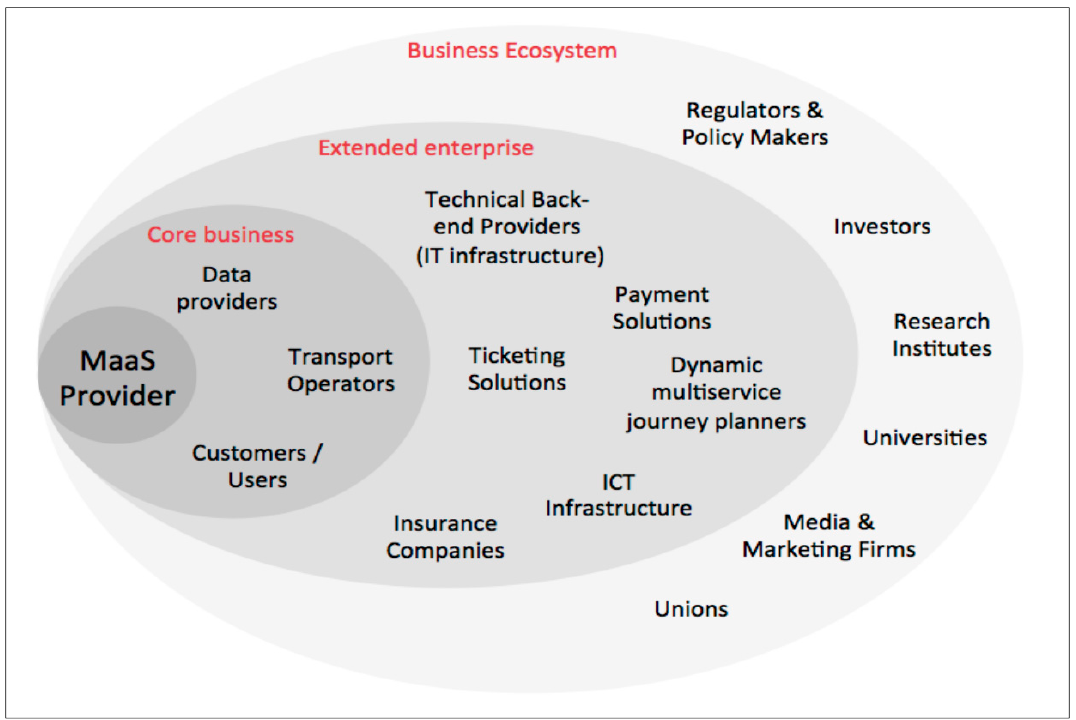
Figure 2. The Mobility as a Service business ecosystem. Reproduced from Kamargianni et al. [12].